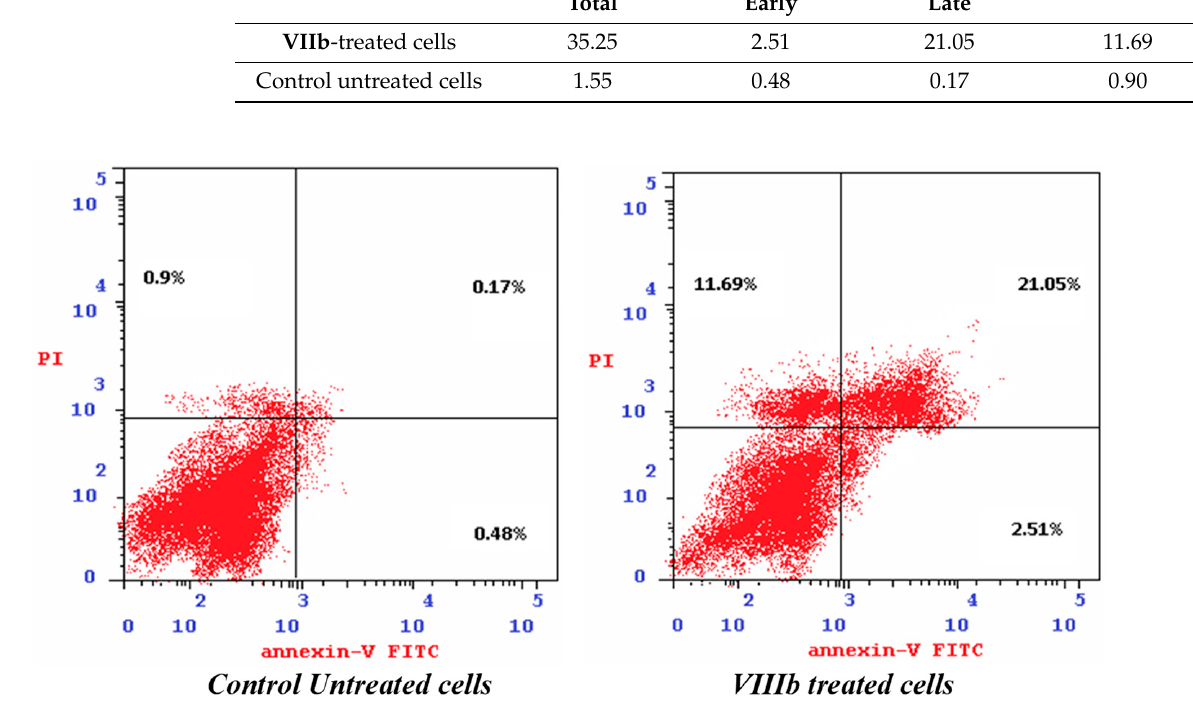
Figure 5. Effect of Compound VIIb on apoptosis induction in MCF-7 cell line.